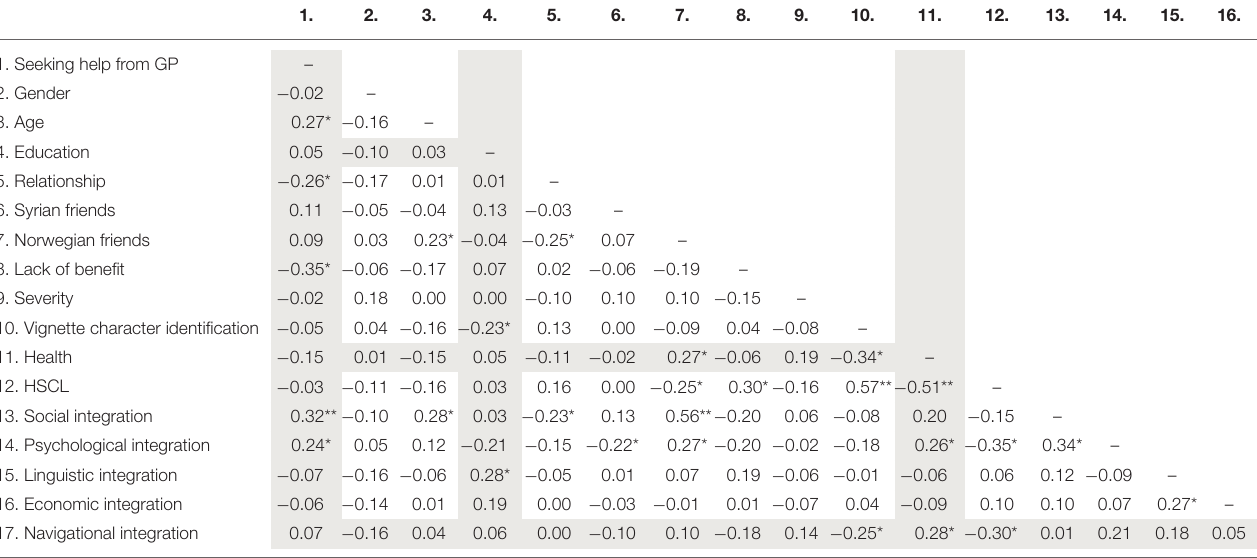
TABLE 2 | Spearman’s rank (in gray) and pearson correlations among study